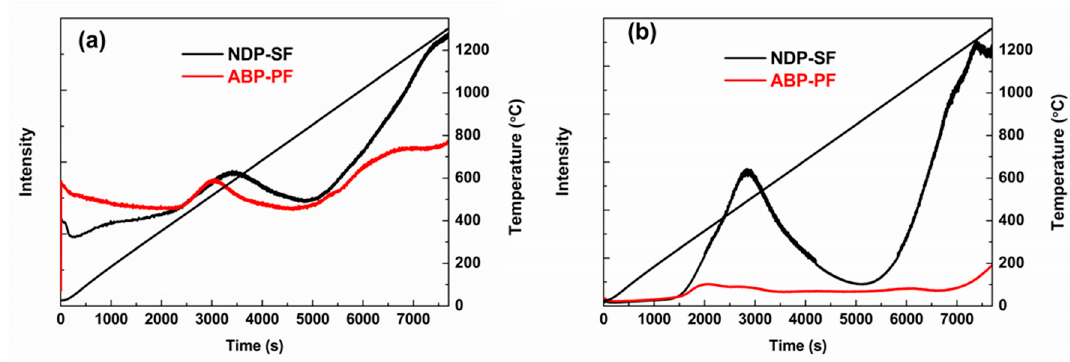
Figure 7. MS curves of NDP-SF and ABP-PF during carbonization process in argon ( a ) CO and ( b ) CO 2 .